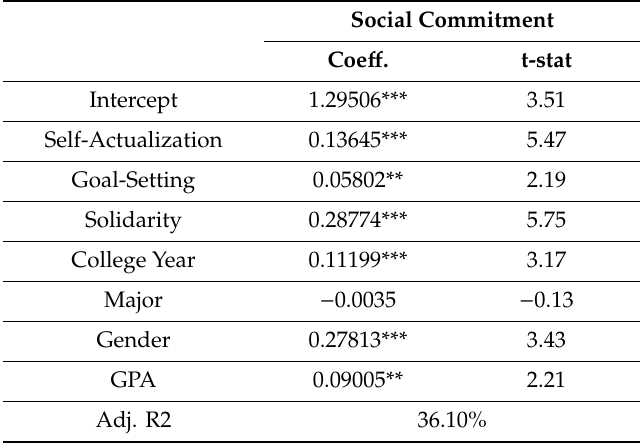
Table 8. E ff ects of the Personal Values on CSV